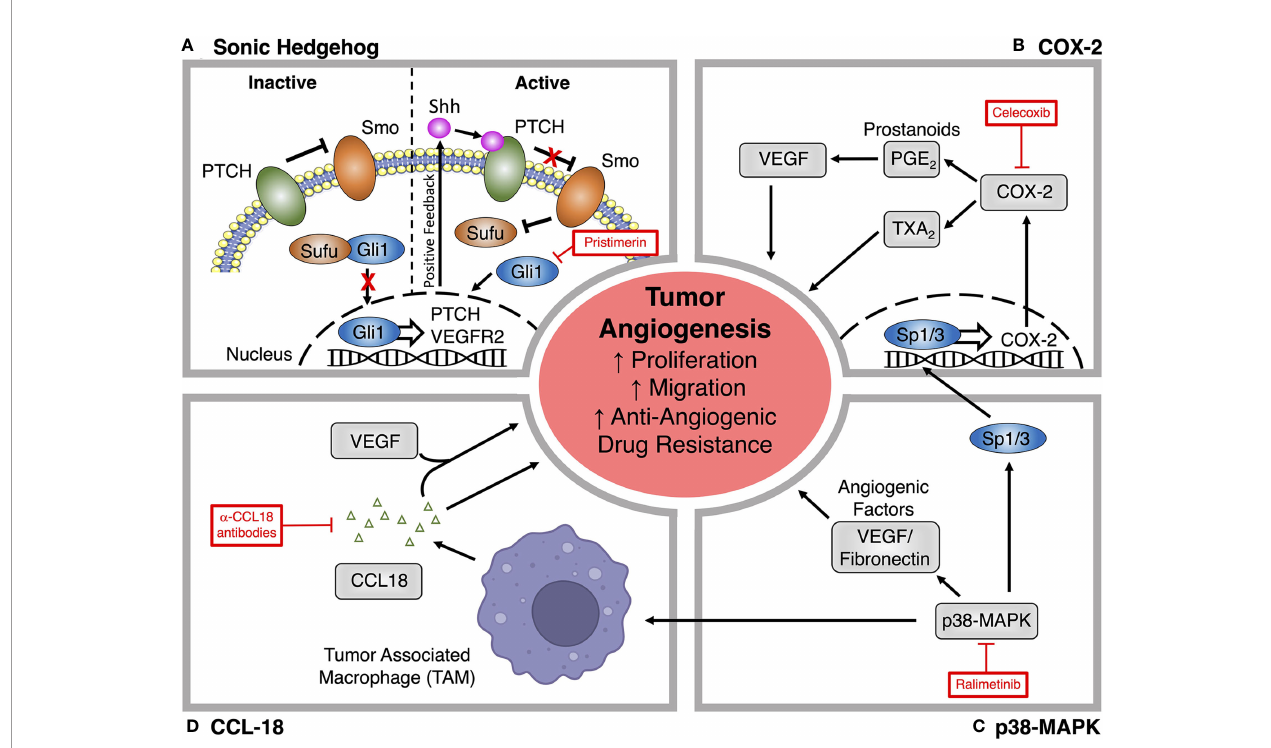
FIGURE 3 | Alternative signaling pathways for targeting tumor angiogenesis. (A) Pristimerin inhibits the pro-angiogenic actions of Sonic hedgehog (Shh) signaling by targeting downstream effects via the transcription factor Gli1. (B) The COX-2 inhibitor Celecoxib prevents the synthesis of downstream prostanoids, which can promote tumor angiogenesis, endothelial proliferation and migration through the production of angiogenic factors like VEGF. (C) Ralimetinib blocks p38-MAPK signaling, which promotes the deposition of angiogenic factors within the tumor microenvironment and can also promote angiogenesis through actions on tumor associated macrophages (TAM) and COX-2 expression. (D) Production of CCL18 by TAMs promotes angiogenesis through VEGF-dependent and independent mechanisms. CCL18 neutralizing antibodies have been explored as a novel treatment for tumor